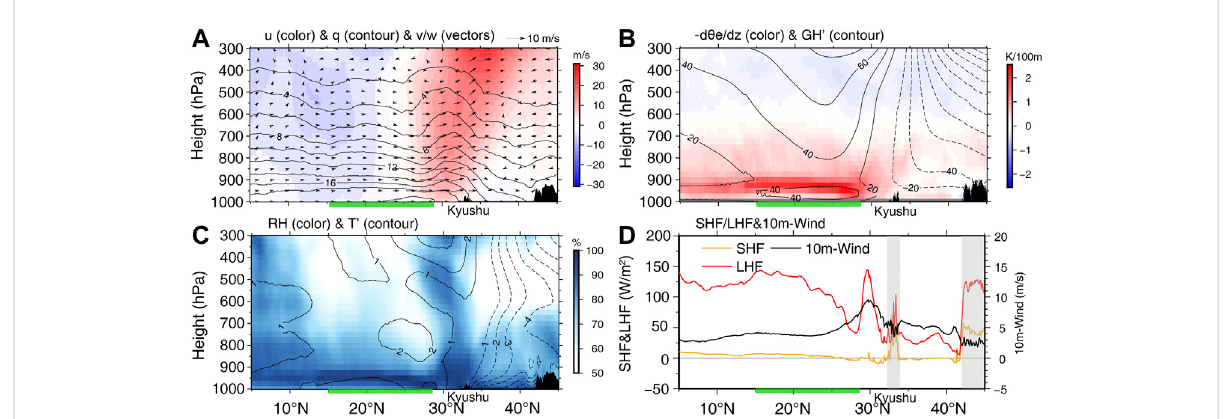
FIGURE 2 Cross-sections along 130 ° E (averaged within 129.5 ° – 130.5 ° E) based on the CTL run averaged from 26 June to 13 July: (A) wind fi elds (color shading and vectors; w is ampli fi ed 50 times for visualization) and speci fi c humidity (q, contours), (B) vertical gradient of the equivalent potential temperature( − d θ e / dz ;colorshadingandpositivemeansunstable)andmeridionalgeopotentialheightanomaly(GH ′ ,contours), (C) relativehumidity (RH, color shading; calculated with respect to ice) and meridional temperature anomaly (T ′ , contours), and (D) sensible heat fl ux (SHF, orange),